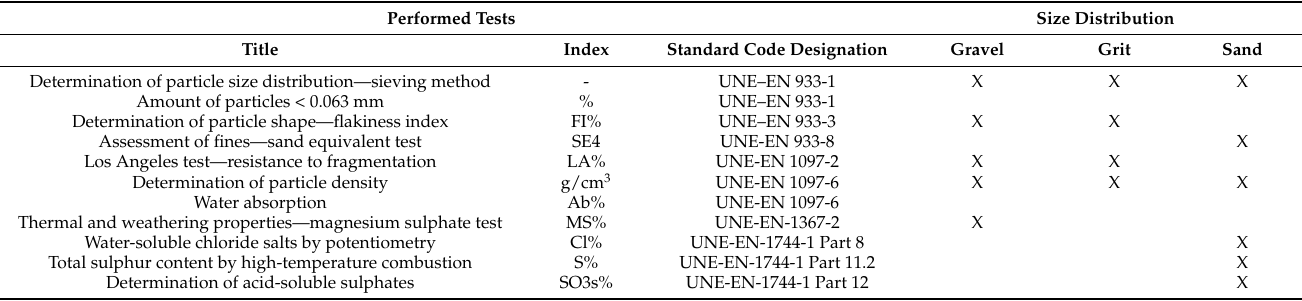
Table 7. Performed tests.